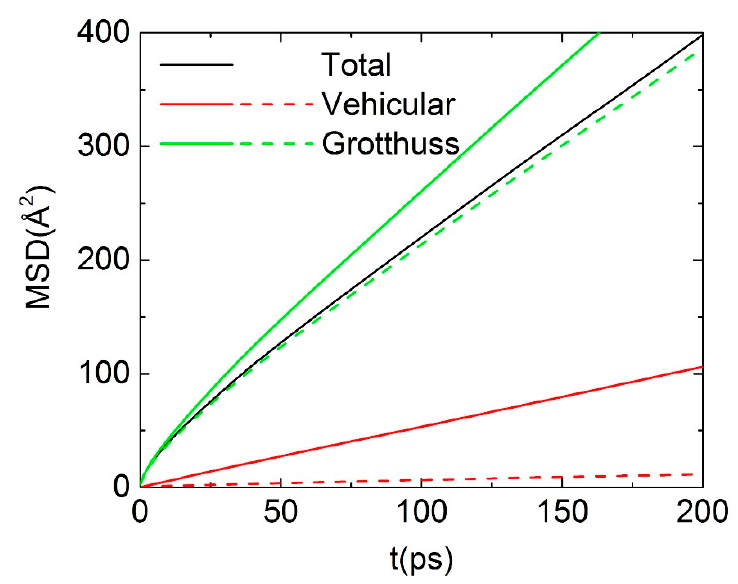
Figure 6. Decomposition of MSD of OH − into Grotthuss hopping and vehicular contribution (ReaxFF only). The dashed lines indicated the net contribution from corresponding diffusion mechanism.